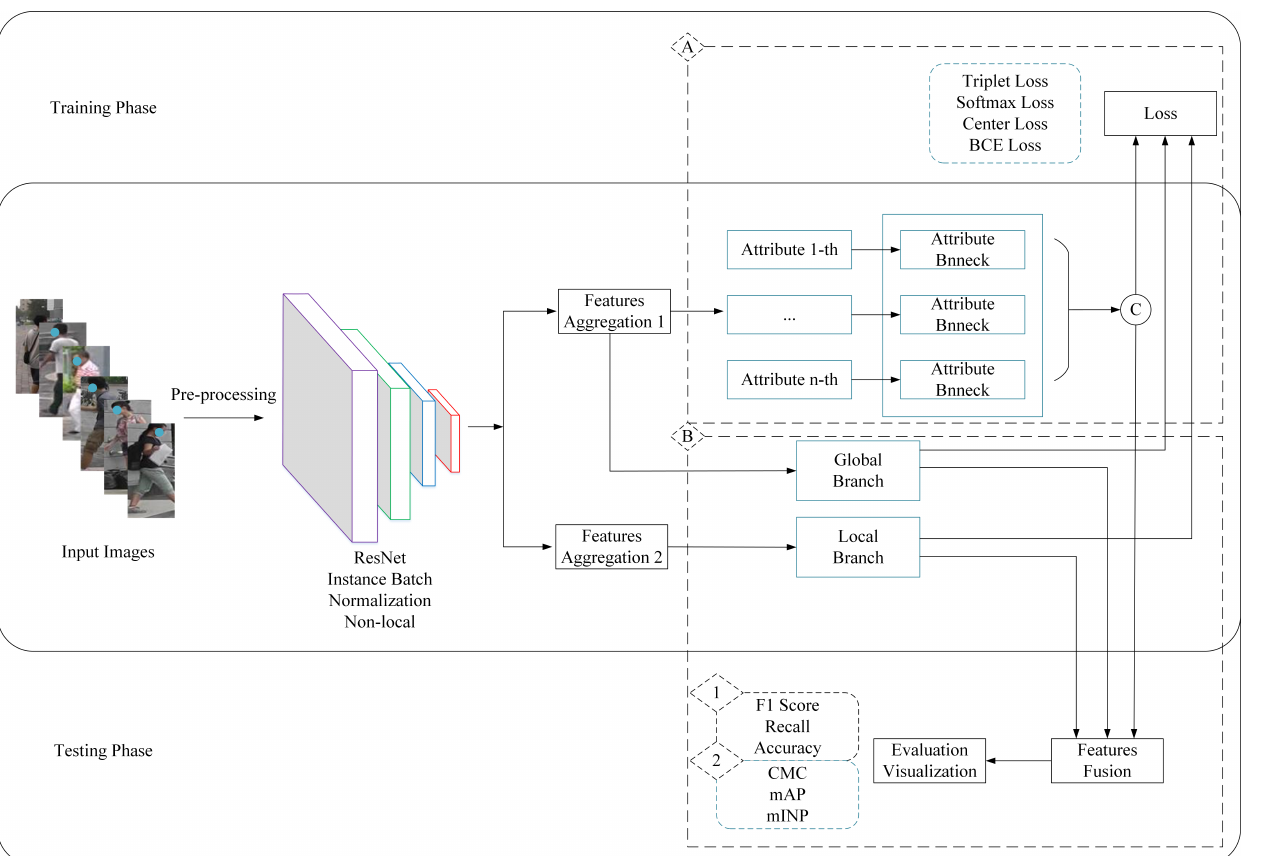
Figure 2. Network structure. It contains two parts: the training and testing phase. The middle part of the figure represents the common part of training and testing. It contains the pedestrian identity and attributes recognition. The training part needs to calculate the loss function, and the model weights are updated using backpropagation. In the test phase, the results of each indicator are output through feature fusion. Backbone uses different colors to distinguish the four different network layers of